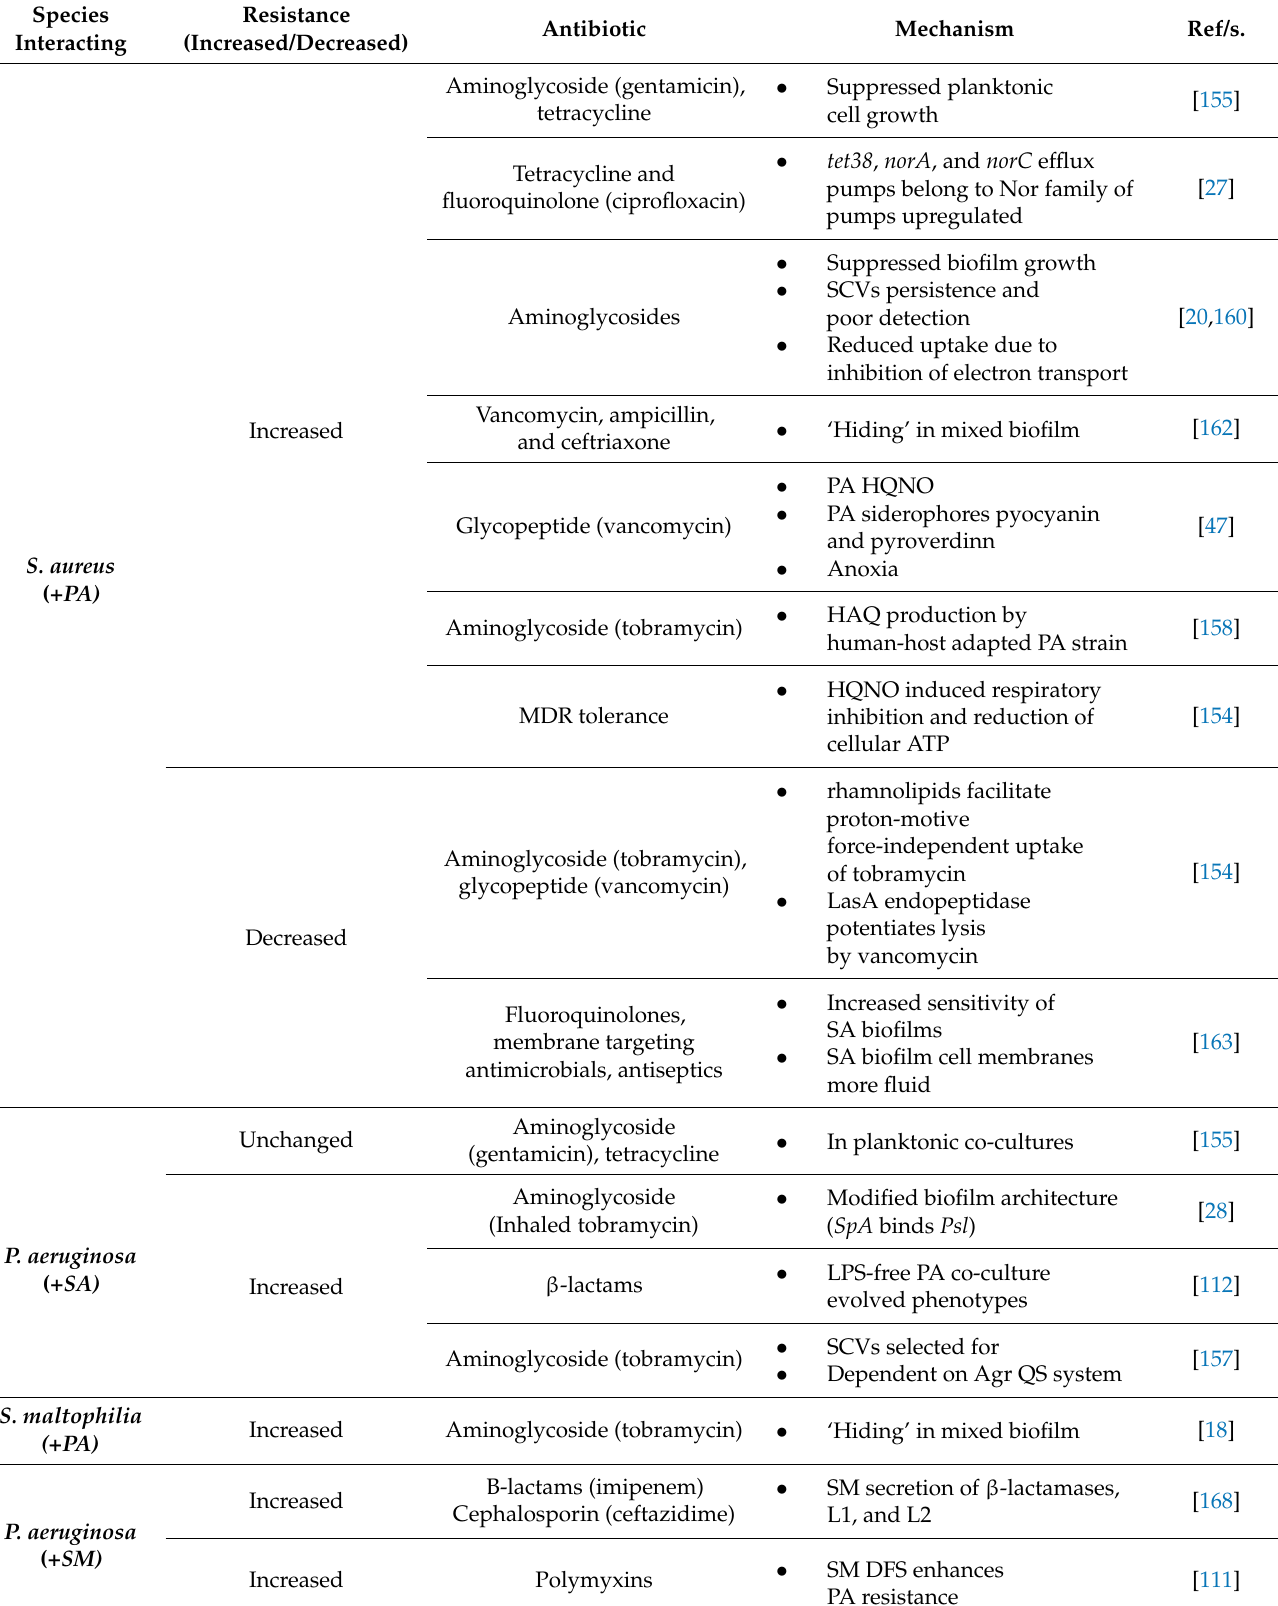
Table 2. Altered resistance or tolerance to antibiotics in co-cultures with P. aeruginosa . Species